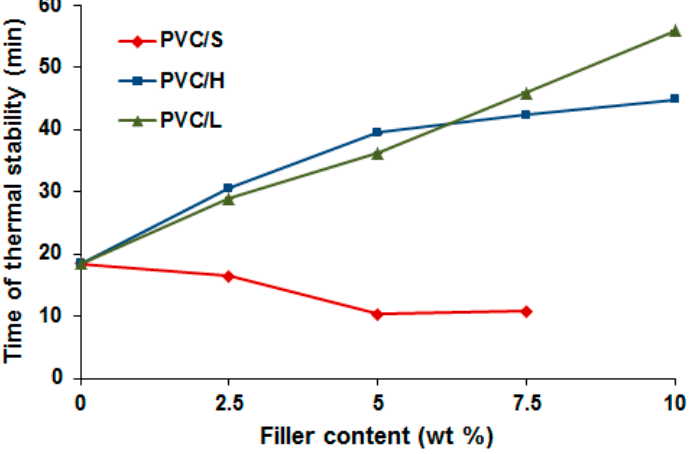
Figure 7. Time of thermal stability of PVC and PVC-based composites vs. filler content (PVC/S, PVC/L and PVC/H).